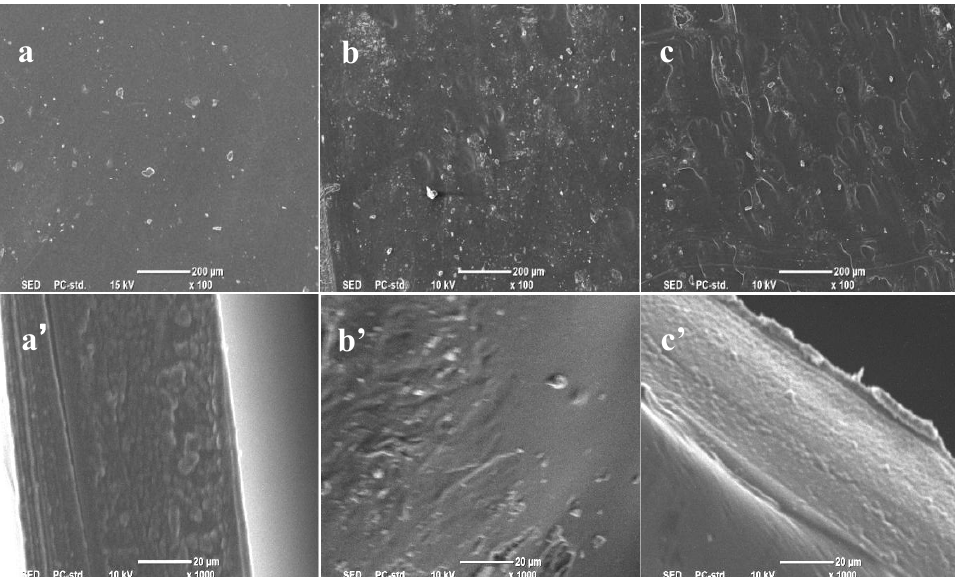
Figure 5. SEM images of jute MCC membranes formed in different coagulation baths: ( a – c ) the surface and ( a’ – c’ ) the cross-section. Note that ( a ) and ( a’ ) are the plan view and cross-sectional view of the membrane formed in water coagulation bath, respectively; ( b ) and ( b’ ) are the plan view and cross-sectional view of the membrane formed in methanol coagulation bath, respectively; ( c ) and ( c’ ) are the plan view and cross-sectional view of the membrane formed in ethanol coagulation